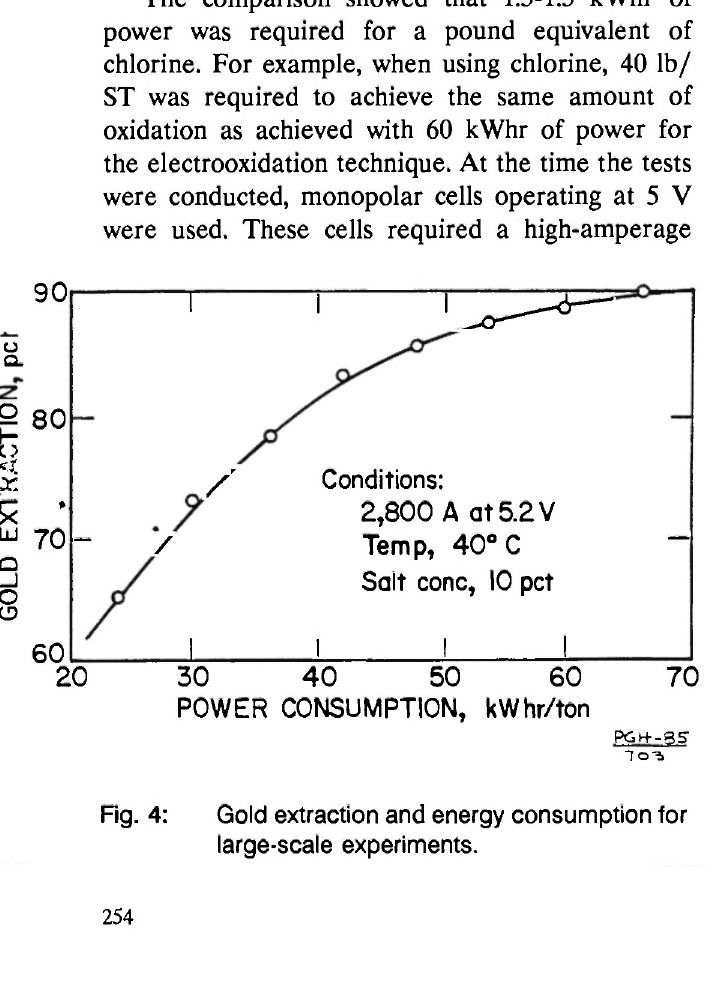
Fig. 4: Gold extraction and energy consumption for large-scale